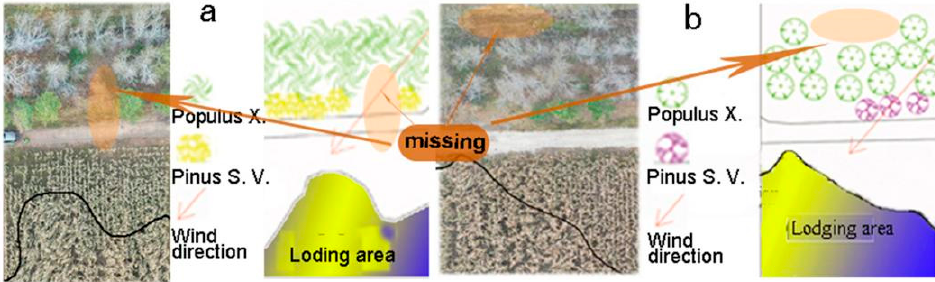
Figure 7. Crop lodging in relation to tree gaps in shelterbelts. The orange area represents missing tree gaps. Black lines indicate the extent of lodging.